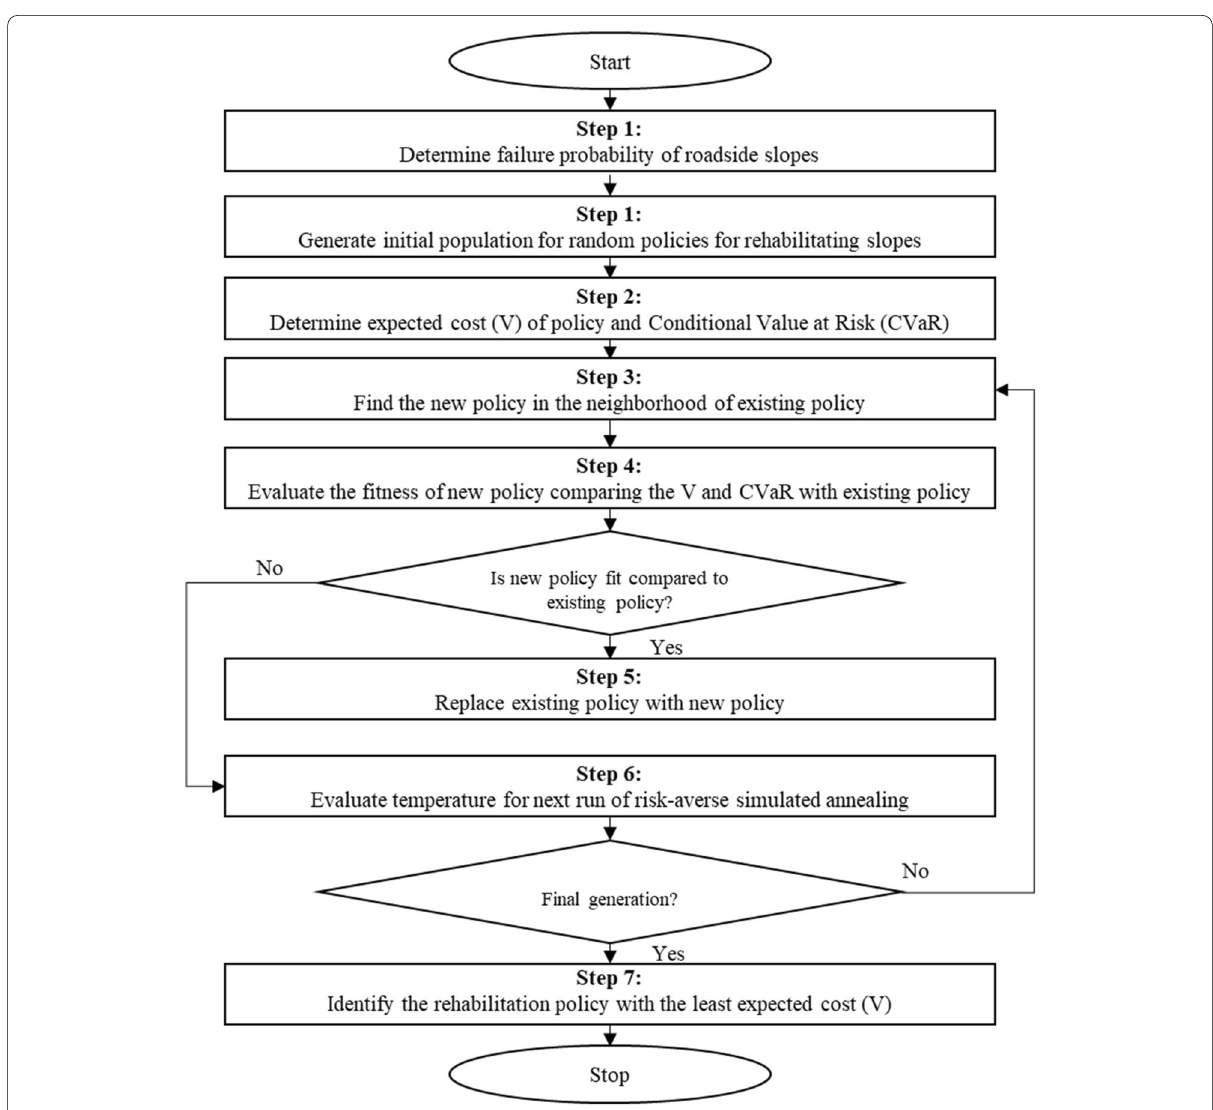
Fig. 3 Steps in the risk-averse simulated annealing